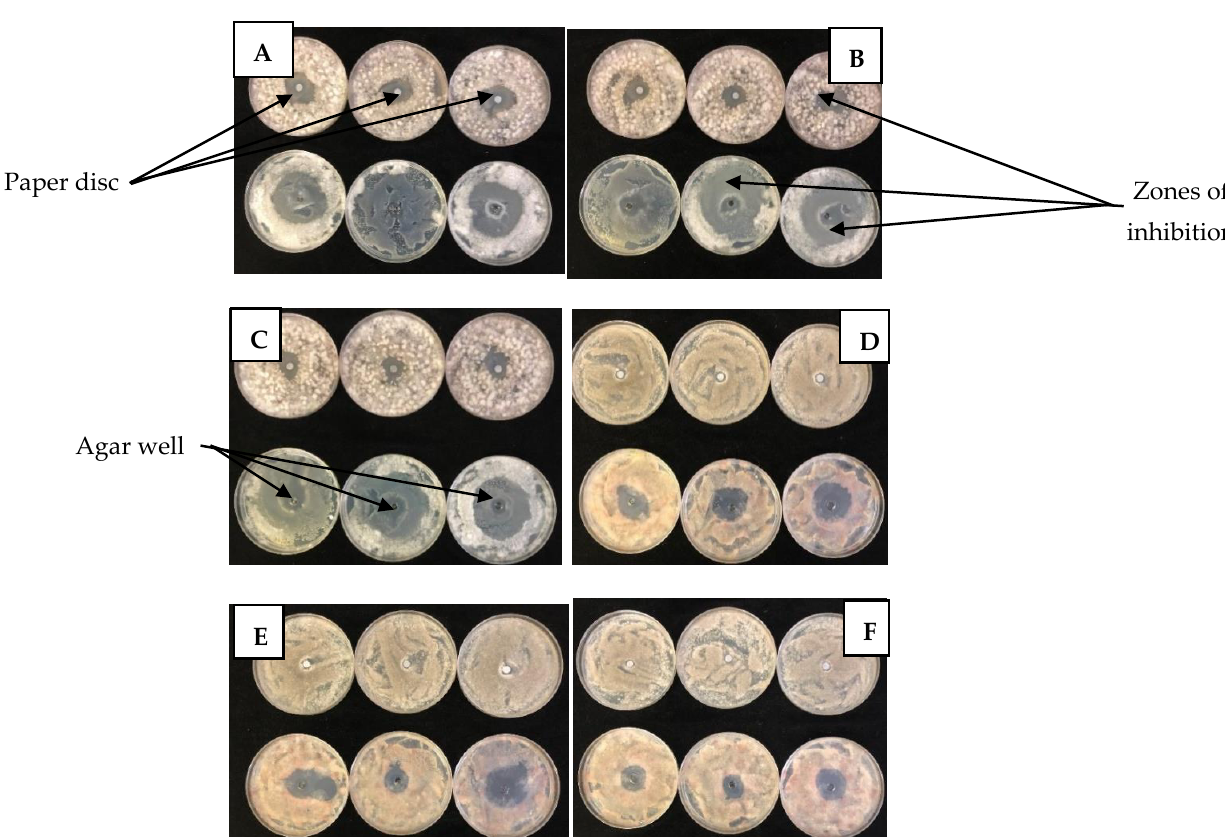
Figure 7. Zones of inhibition obtained by paper disc and agar well diffusion methods testing lemongrass essential oil at different concentrations (( A ) = 1 µL/mL; ( B ) = 0.5 µL/mL; ( C ) = 0.3 µL/mL; ( D ) = 0.1 µL/mL; ( E ) = 0.05 µL/mL; ( F ) = 0.02 µL/mL) against Botrytis cinerea on day 4 after inoculation and incubation at 26 °C in the dark.